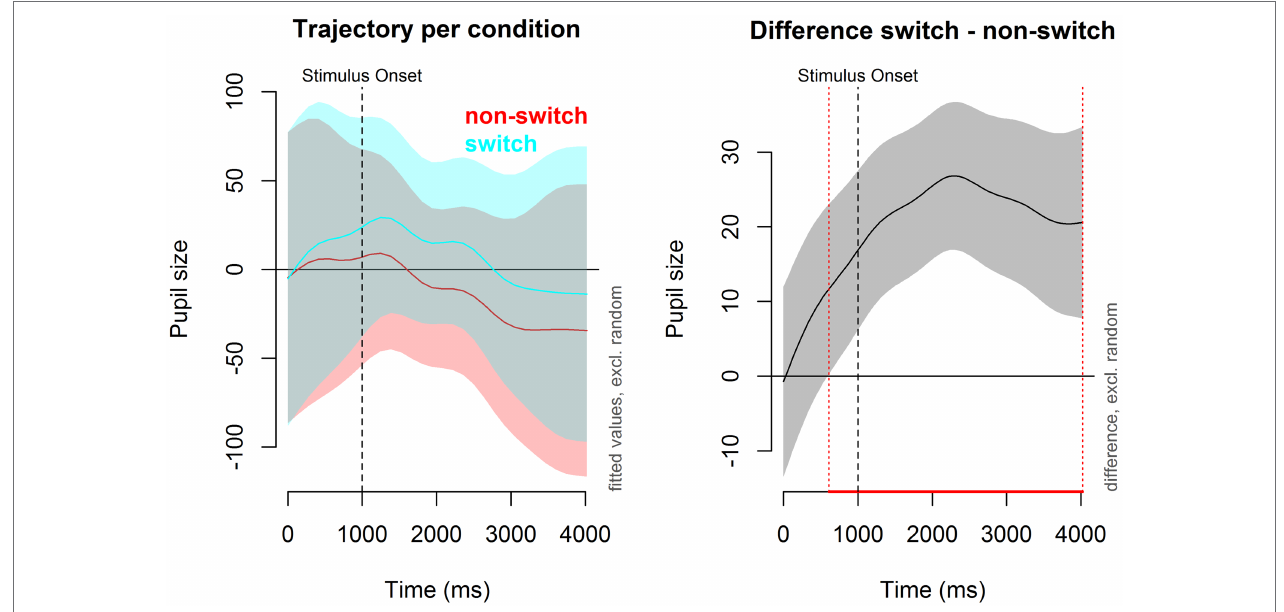
FIGURE 4 | Pupil dilation per trial type over time. Left panel : Pupil dilation (in arbitrary units) for switch trials (blue) and non-switch trials (red). Time ( x -axis) starts at cue onset. The black dotted line at 1,000 ms represents the stimulus onset. Right panel : Pupil switching cost. The red dotted line represents the moment the difference in pupil size between switch and non-switch trials became significant.